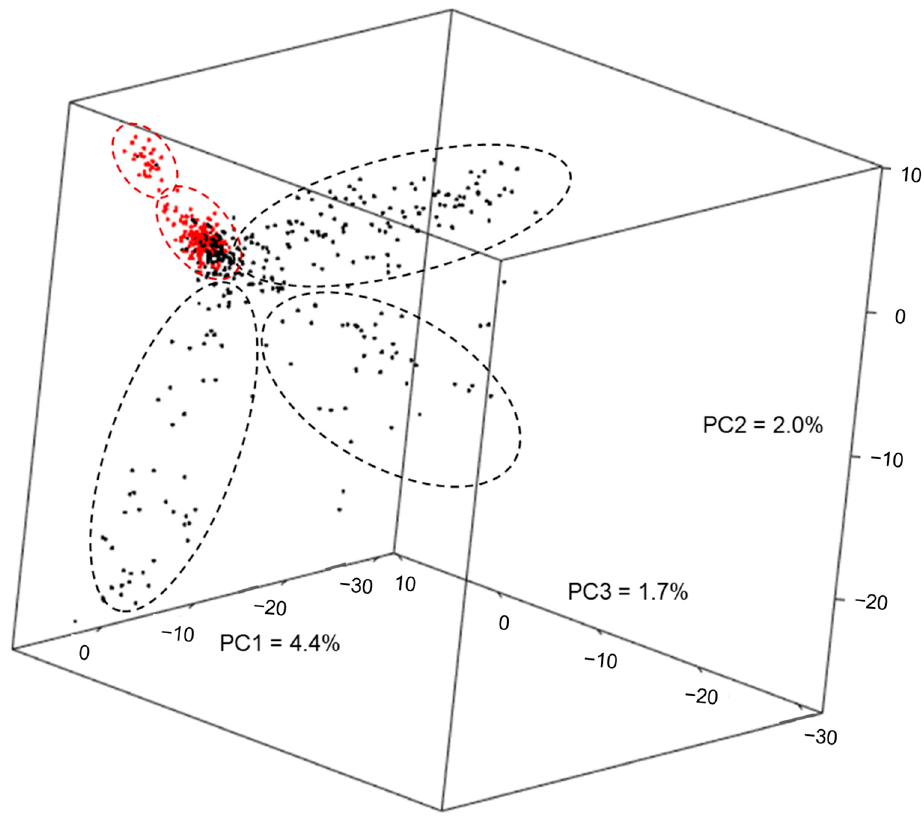
Figure 1. Principal component analysis of 563 inbred lines, including 365 lines from Embrapa (black dots) and 198 from DTMA panel (red dots) based on the first three principal components (PC). The percentages represent the genetic variance explained by each PC. The dashed black circles indicate three clusters of Embrapa lines (black dots) representing Flint, Dent and C groups; and the dashed red circles indicate two clusters of DTMA lines (red dots).